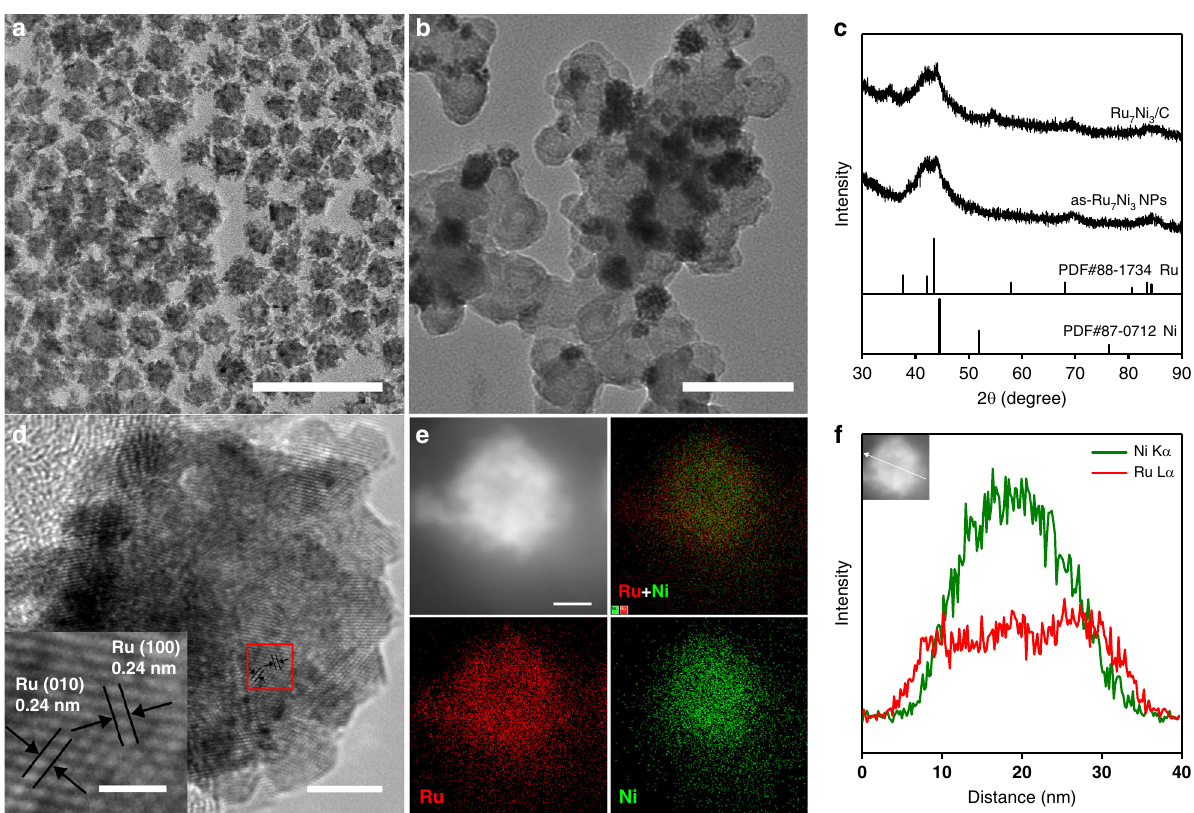
Fig. 1 Characterizations of the Ru 7 Ni 3 /C catalysts. a Transmission electron microscopy (TEM) image of the as-Ru 7 Ni 3 NPs (scale bar, 100 nm). b TEM image of the Ru 7 Ni 3 /C catalyst (scale bars, 100 nm). c The X-ray powder diffraction (XRD) patterns of the as-Ru 7 Ni 3 NPs and Ru 7 Ni 3 /C. d High-resolution TEM (HRTEM) images of the Ru 7 Ni 3 /C (scale bar, 5 nm). Inset shows the corresponding red box region (scale bar, 1 nm). e High-angle annular dark- fi eld (HAADF) scanning TEM (STEM) image and corresponding energy-dispersive X-ray spectrometry (EDX) mapping showing the distribution of Ru and Ni of a nanoparticle in Ru 7 Ni 3 /C (scale bar, 10 nm). f EDX line-scanning pro fi le of a nanoparticle in Ru 7 Ni 3 /C. Inset shows the HAADF-STEM image of the corresponding nanoparticle.